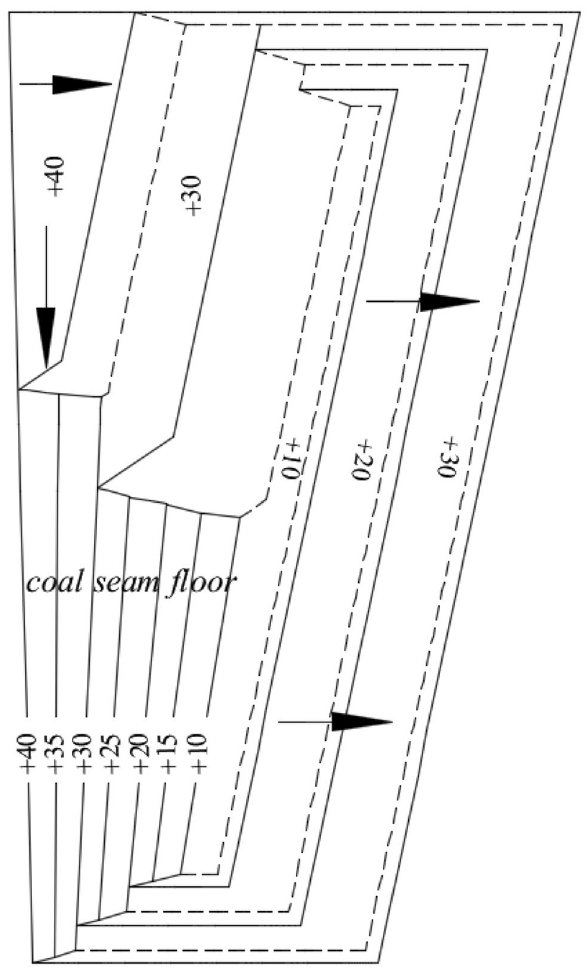
Fig. 8 Layout and development of internal dump working line in steeper anticline region